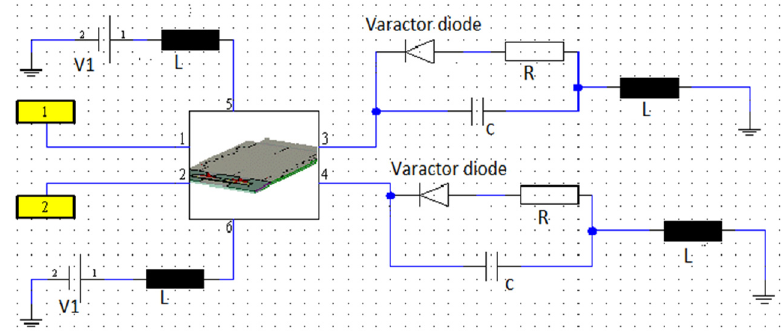
Figure 5. Schematic part of the SIW variable phase shifter and equivalent circuits of the varactor diodes. Table 2. Phase shifter angle and capacitance as a function of biasing voltage.